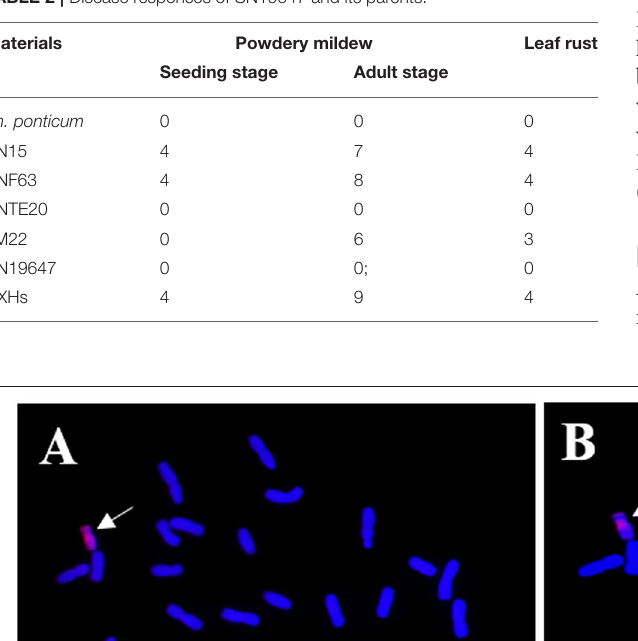
TABLE 2 | Disease responses of SN19647 and its parents.